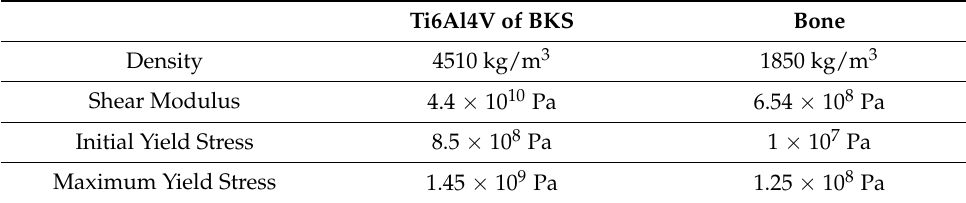
Table 1. Mechanical Properties [23].